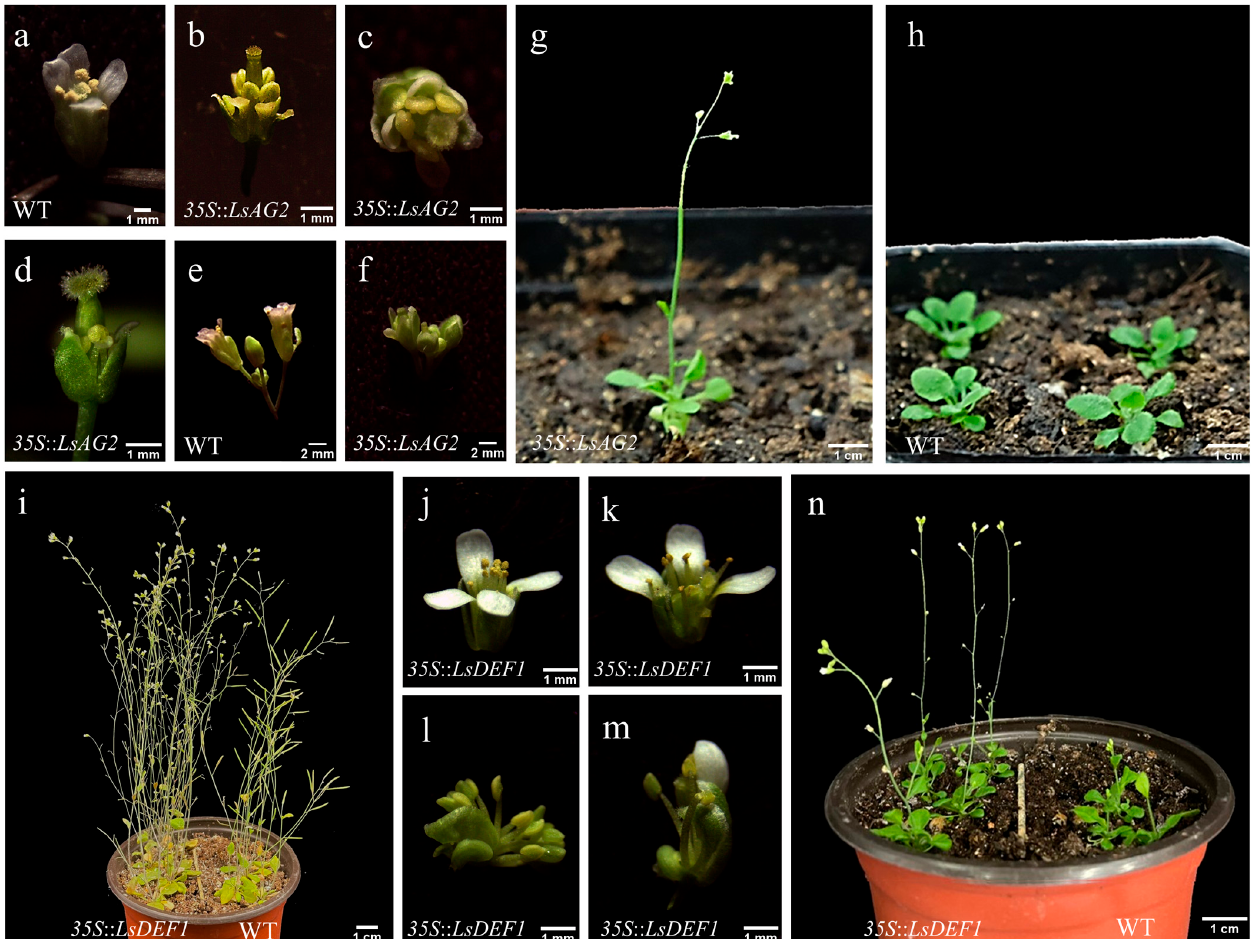
Figure 4. Phenotypes of overexpression of LsAG2 and LsDEF1 in Arabidopsis. ( a ) Flower of wild-type A. thaliana . ( b – d ) Flowers of 35S :: LsAG2 transgenic A. thaliana . ( e ) Inflorescence of wild-type Ara-